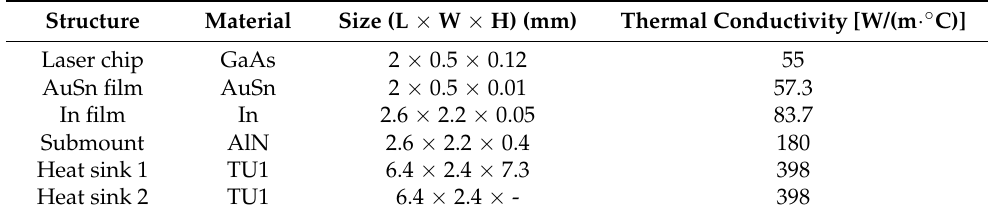
Table 1. Parameters related to the device’s structure materials.